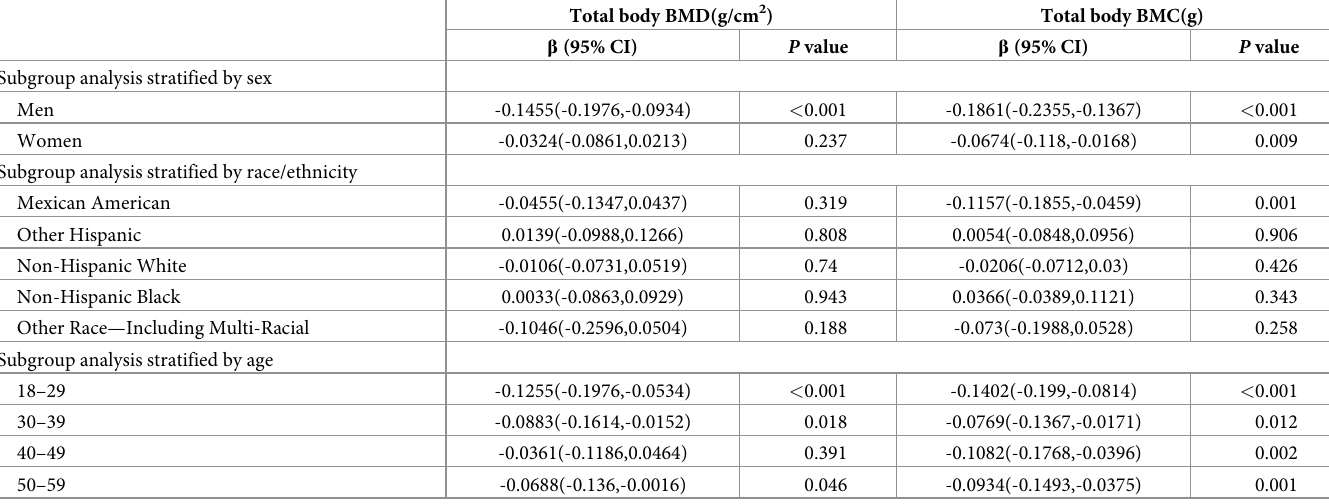
Table 6. Association of blood manganese with total body BMD/BMC, stratified by sex, race/ethnicity and